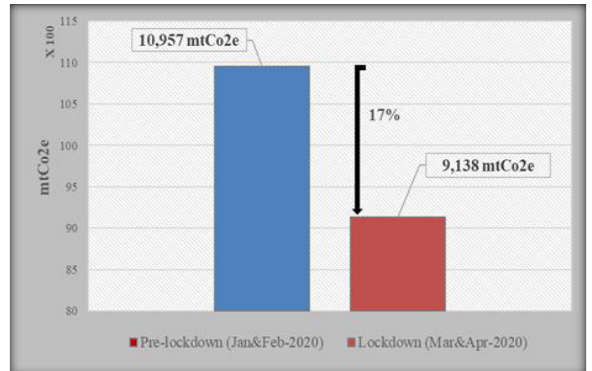
Figure 1. Comparison of the carbon footprint associated with electricity consumptions in pre-lockdown and lockdown period.